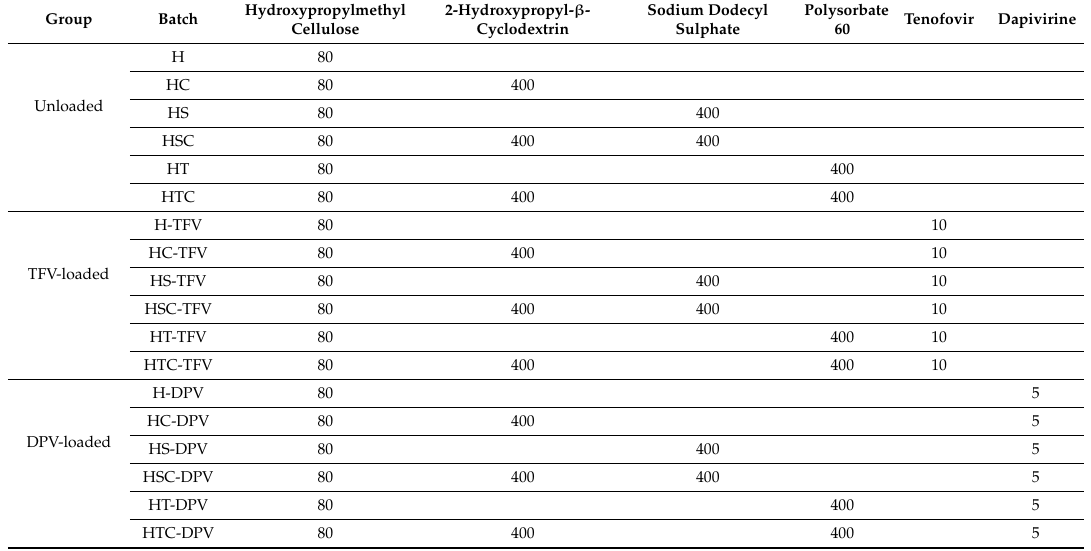
Table 1. Composition of vaginal discs